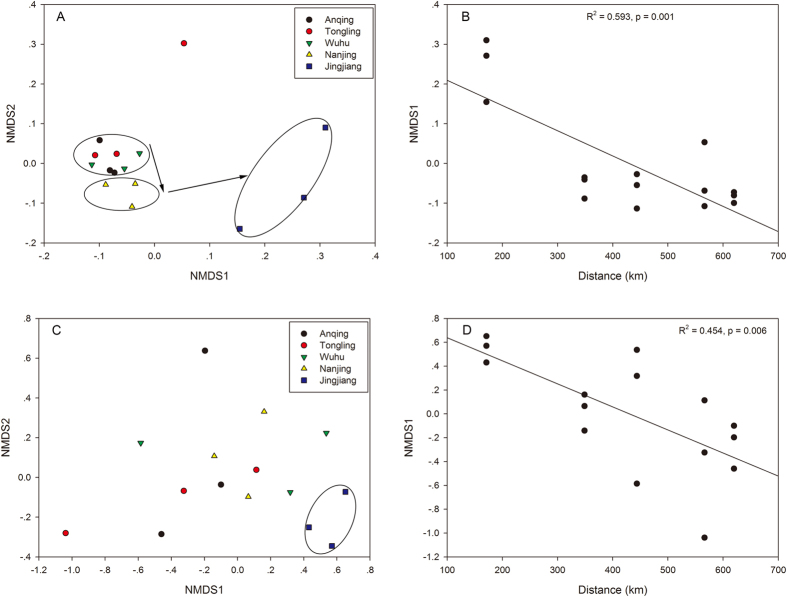
(A,C) NMDS plots of the first and second NMDS dimensions relating bacterial and archaeal community compositions respectively between sampling sites. Symbols representing communities present in each sampling site are as follows: Anqing, Tongling, Wuhu, Nanjing and Jingjiang. Percentages given in axes labels are the % variation in community composition explained by the respective NMDS dimensions. (B,D) Linear regression of the distances between sampling sites and mouth of estuary versus dimension 1 of the NMDS analysis. The strength of the linear relationship is indicated by the regression coefficient (R2) on the plot.